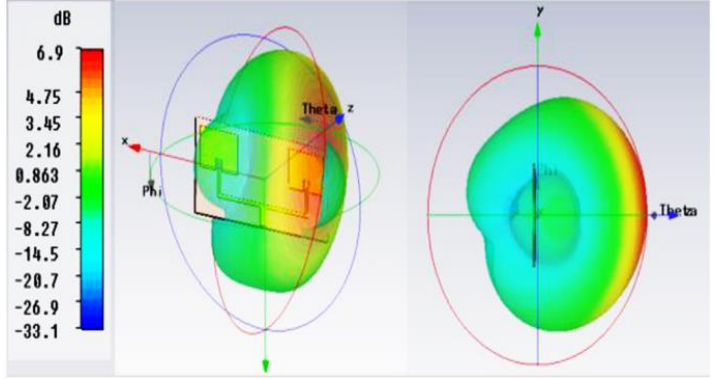
Figure 9. Radiation diagram and simulated 2 × 1 array gain.